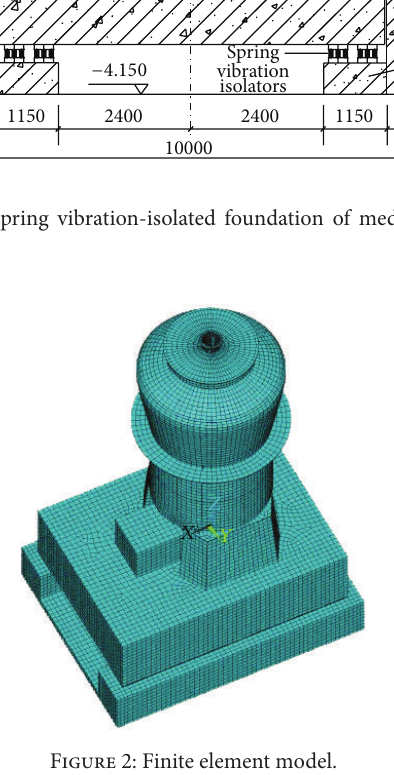
Figure 2: Finite element